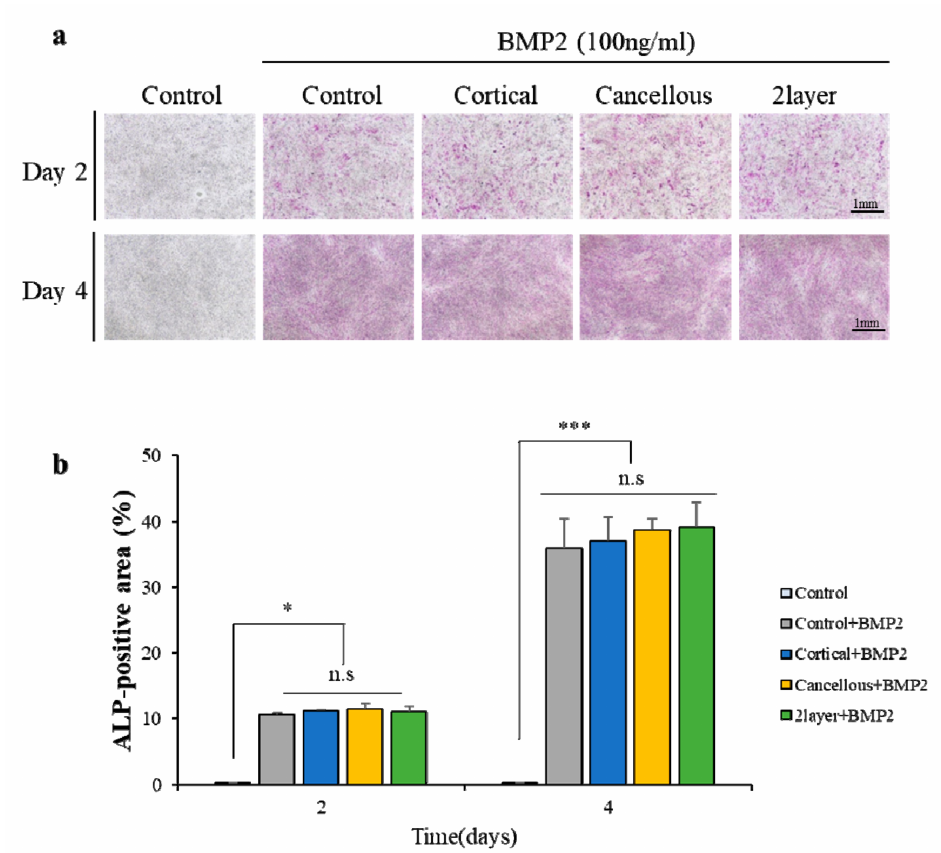
Figure 5. Pre osteoblast cells differentiation. ( a ) Alkaline phosphatase (ALP) staining of pre- osteoblastic BRITER cells in osteogenic media with BMP2 that diluted each bone block substitute extract solutions and ( b ) quantitative analysis (n.s represents no significance, * p < 0.05, *** p <